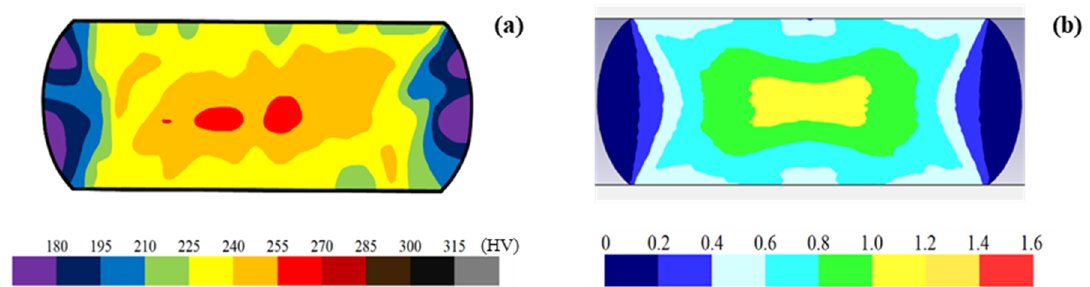
Figure 8. Comparison of the cross-sectional shape and hardness mapping of forged pure titanium at r = 50 % with the simulated shape and equivalent strain distribution by finite element analysis. ( a ) Experimentally measured cross-section of titanium wire at r = 50% with hardness map, and ( b ) deformed finite element model and calculated equivalent strain distribution by FEA.